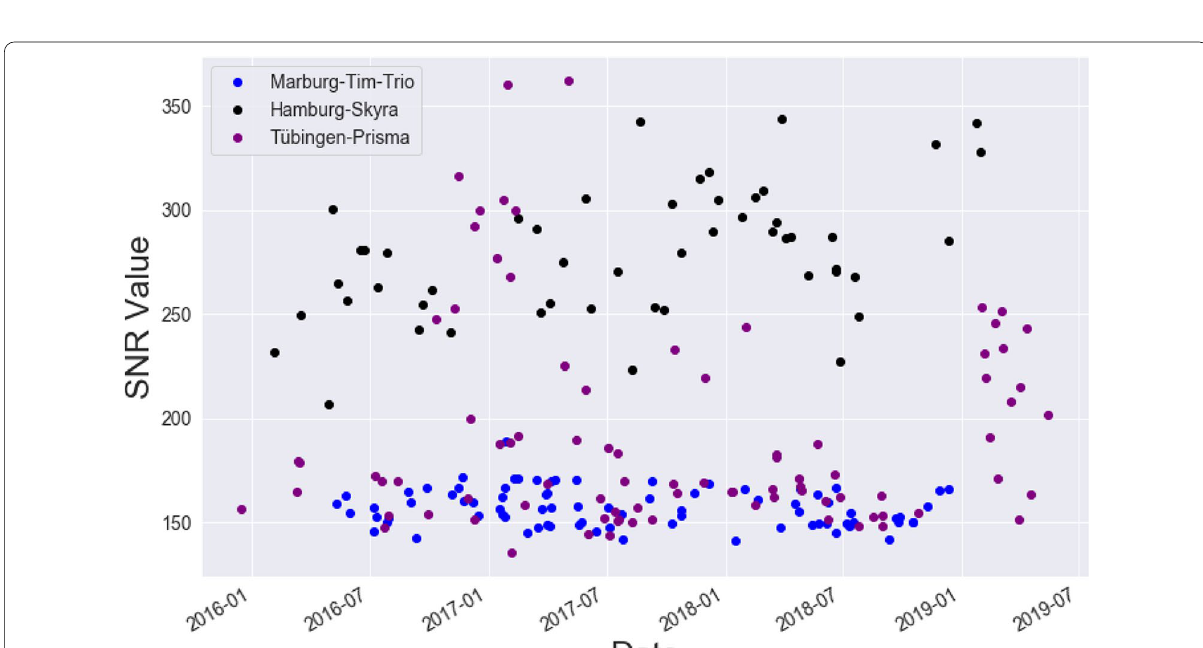
Fig. 5 Signal-to-Noise Ratio (SNR) values of phantom measurements of three different BipoLife sites across time. The MR scanner of Marburg (Siemens Tim Trio, blue) shows stable values, but a lower SNR value compared to Hamburg (Siemens Skyra, black) or Tübingen (Siemens Prisma,